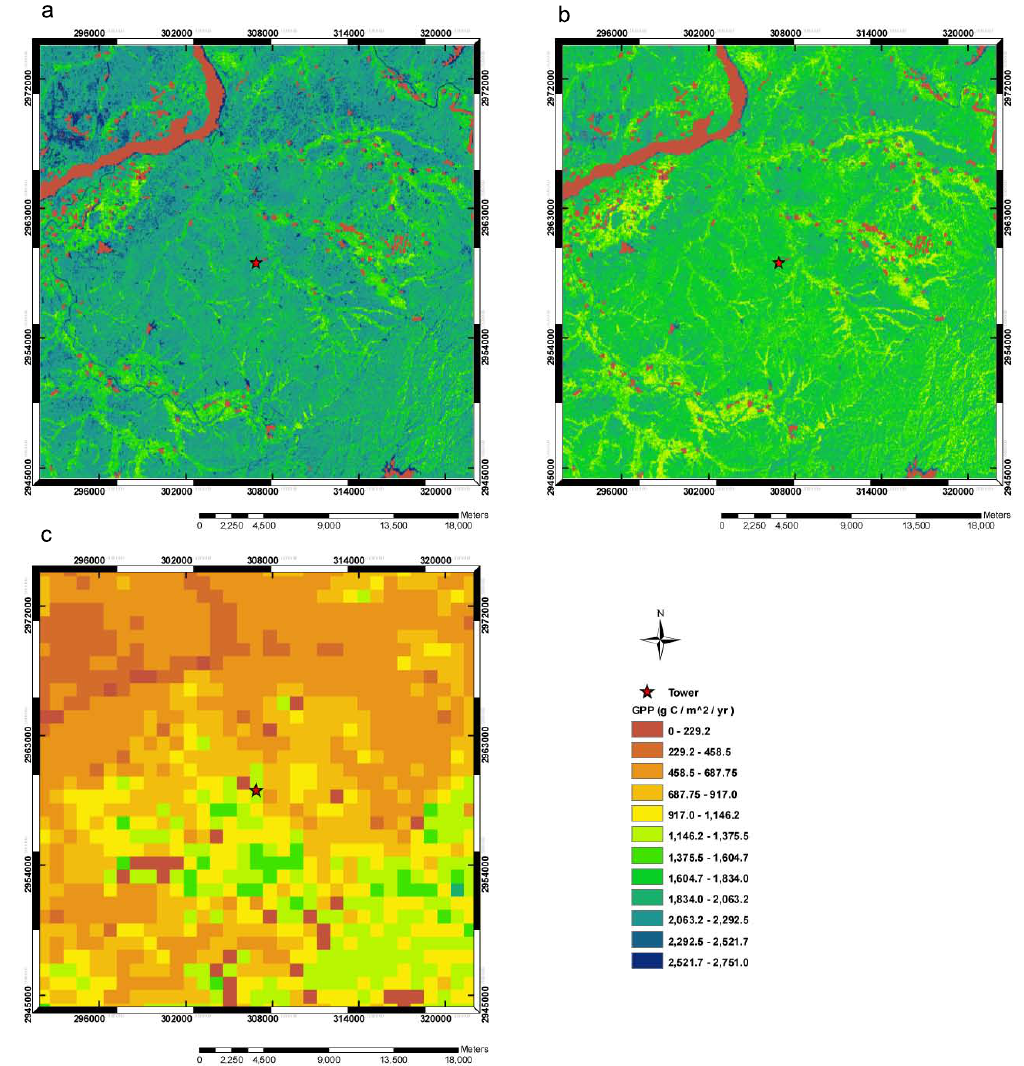
Fig. 5. Remotely-sensed annual total gross primary production (GPP) map for 2004 at a 30-m resolution over a 30km × 30km region centred at the QYZ tower modelled using VPM with default (a) and optimized (b) parameters. The MODIS products at 1-km resolution are also shown for